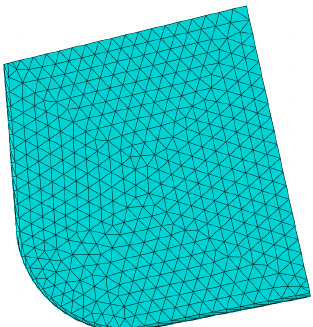
Figure 3. FEA mesh model of cutting tool. Figure 3 . FEA mesh model of cutting tool. Figure 3 . FEA mesh model of cutting tool.